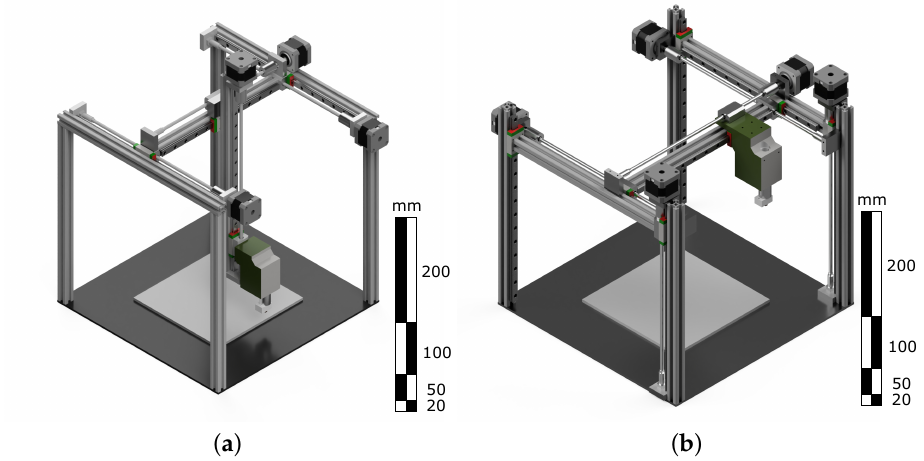
Figure A1. 3D model of 3D printers with fixed axes X B , Y B , Z B and actuated axes X H , Y H , Z H ( a ) with closed X H , Y H and open Z H axes ( b ) with closed axes X H , Y H , Z H .